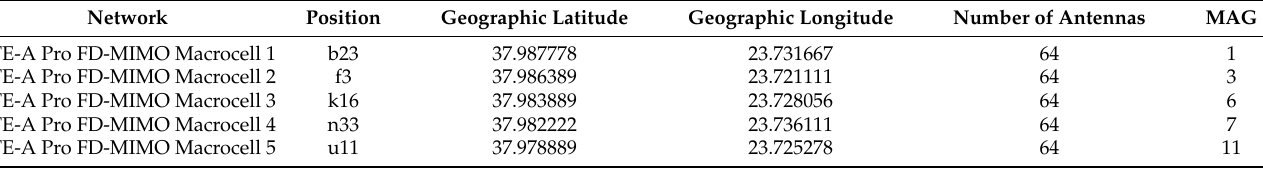
Table A2. The positions and the frequencies of the simulated LTE-A Pro FD-MIMO